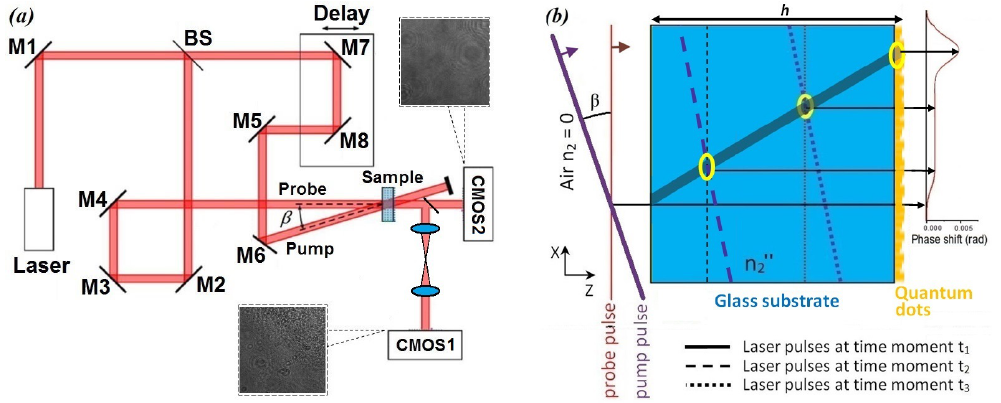
Figure 1. ( a ) A scheme of the experimental setup for the recording of inline digital hologram data set in the TRIDH experiment. ( b ) A scheme of two femtosecond laser pulse propagation inside the sample and probe pulse NDPM-induced phase shift in the XZ plane. Pulses propagation is from the left to right according to the red and purple arrows. The location of both femtosecond pulses in three time moments are denoted with solid, dash, and dotted lines. The plot on the right indicates the amount of phase shift induced in the probe pulse at each point of the X-axis. The gray semitransparent area indicates the pulse intersection area, and the blue and orange indicate the glass substrate and deposited